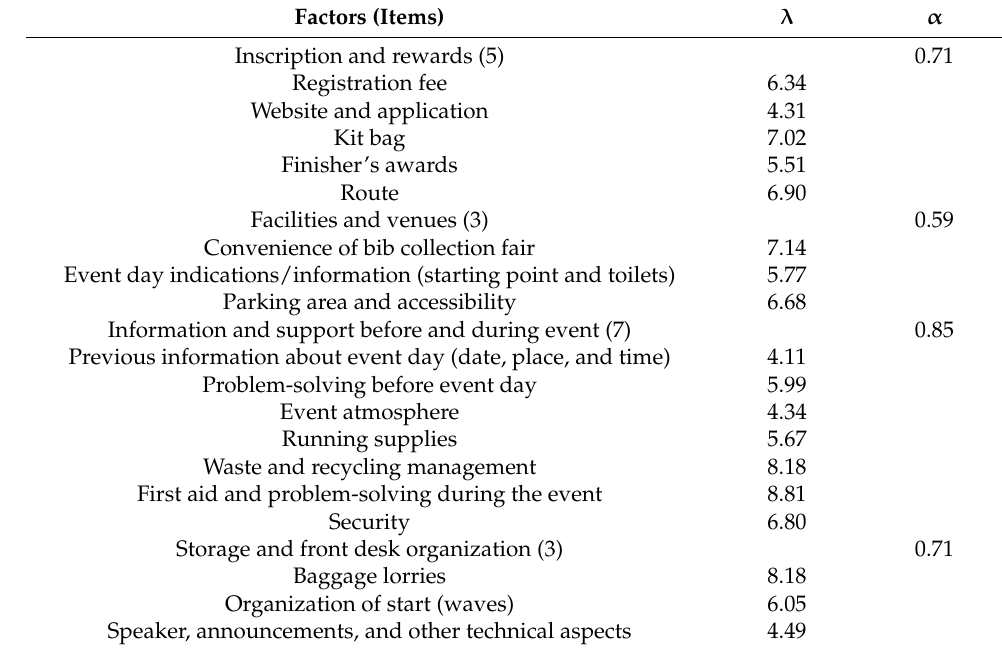
Table 4. Factorial analysis: final factor loadings ( λ ) and Cronbach’s alpha ( α ) for performance